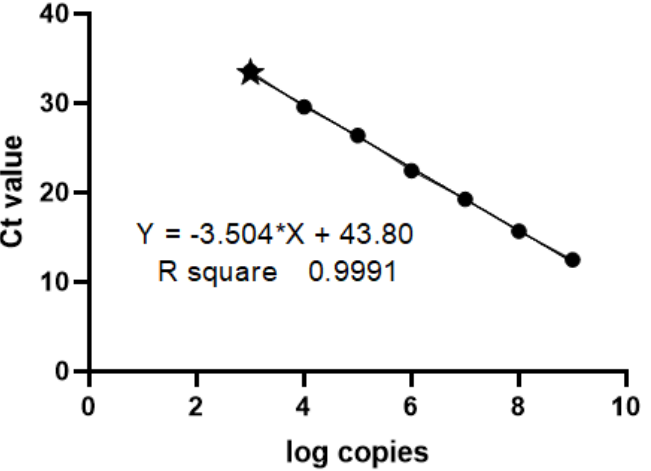
Figure 3 . The relationship between the initial copy number of the template in the reaction and the Ct value for primer pair 2 (fqfum6ve2 andfqfum6ve3) to FUM6 gene. *The star indicates the log copy number/Ct value of the FUM6 gene in the maize sample 1 which gave positive signal with this pair of primers.